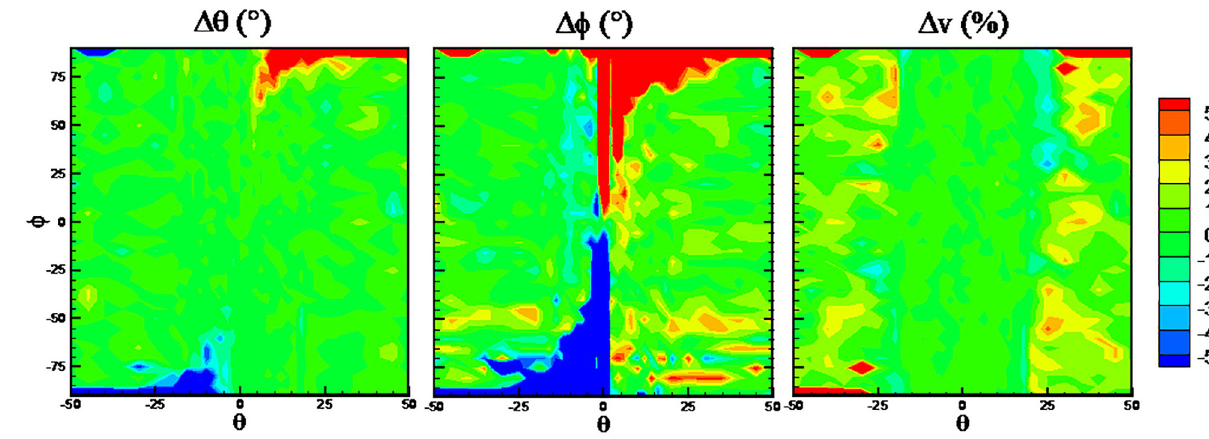
Fig 19. Error distributions with RFs